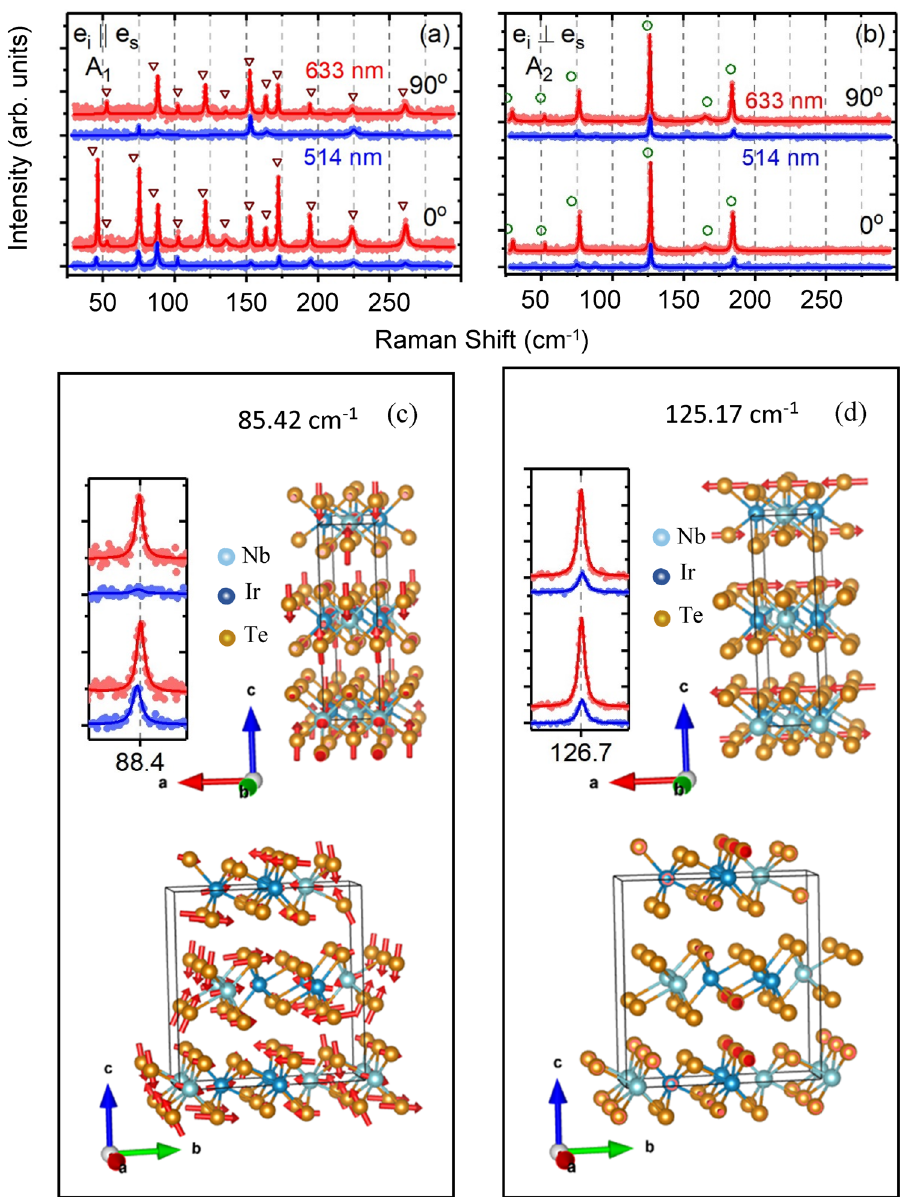
Figure 2. Polarized Raman spectra of NbIrTe 4 nano-flake as a function of rotation angle. ( a , b ) Raman spectra for two selected angles (0°, 90°) between polarization direction of the incident beam and a-axis of the sample, respectively, for parallel and cross configurations. Red and blue lines are Lorentz fittings of the Raman spectra measured with 633 nm and 514 nm laser excitation, respectively. Dark red triangles and green circles illustrate the calculated Raman frequencies of the detected modes by Density Functional Theory belonging to the A 1 and A 2 irreducible representations, respectively. ( c , d ) Simulated normal modes of given frequencies calculated by the Density Function Theory at two perspectives for a one selected A 1 mode at 85.42 cm −1 and one selected A 2 mode at 125.17 cm −1 , respectively. The direction of arrows shows the direction of the atoms vibration and magnitude of arrows represent relative amplitude of atoms